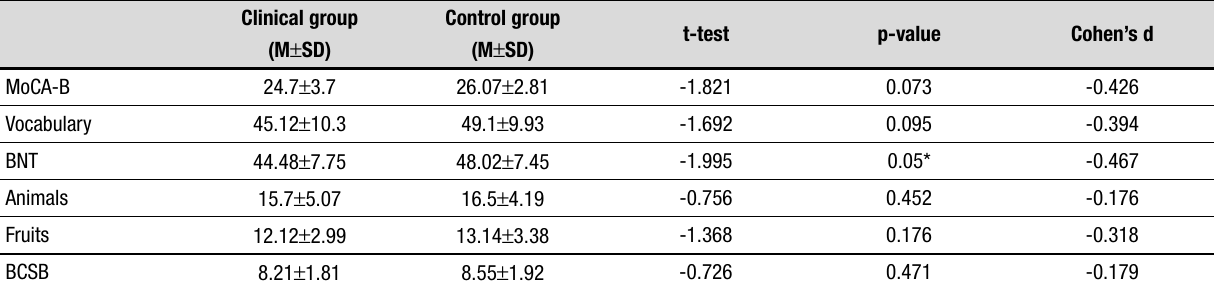
Table 2. Sample performance.